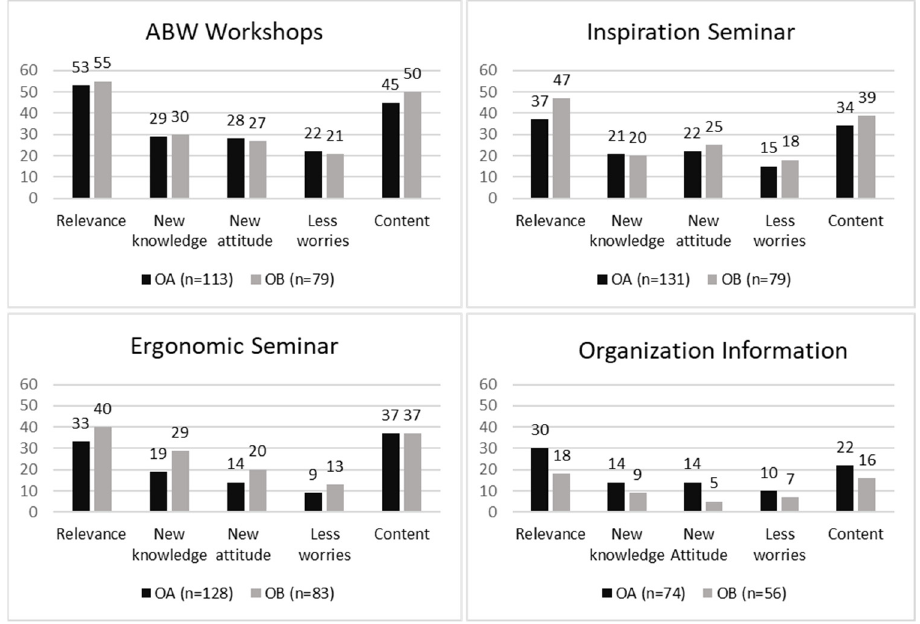
Figure 2. The percentage of employees reporting high satisfaction with the aspects of relevance, increased knowledge, changed attitude, decreased worries, and content in the program activities.